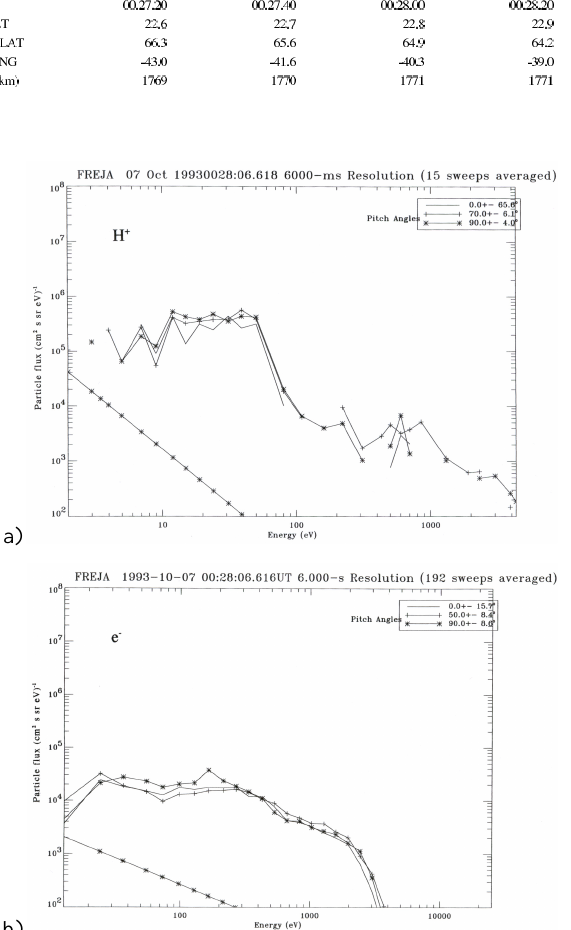
Fig.15. A 2-min CSP showing precipi- tating ions with strongly decreasing en- ergy (00:27:30–00:28:12UT).